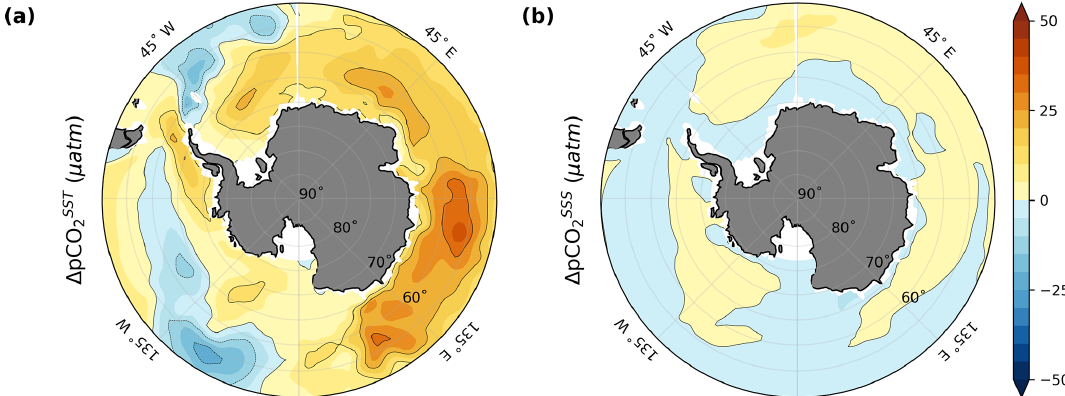
Figure A3. Maps of individual pCO 2 contributions (µatm) from (a) SST (corresponding to the brown triangle in Fig. 3a) and (b) SSS (corresponding to the magenta triangle in Fig. 3a).